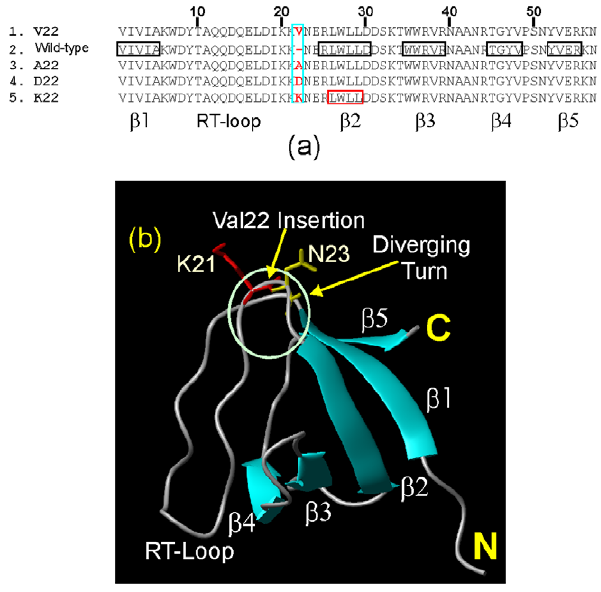
Figure 1. Sequence and structure of the first hNck2 SH3 mutants. (a). Sequence alignments of different hNck2 SH3 proteins with secondary structure regions boxed and labelled. 1. V22-SH3 previously derived from the hNck2 sequence AAC04831 with an extra Val insertion at position 22. 2. wild-type SH3. 3. A22-SH3 with the extra Val22 mutated to Ala. 4. D22-SH3 with the extra Val22 mutated to Asp. 5. K22-SH3 with the extra Val22 mutated to Lys. (b). The published NMR structure of the first hNck2 SH3 domain (2B86) with the secondary structures and position of the inserted Val residue indicated.